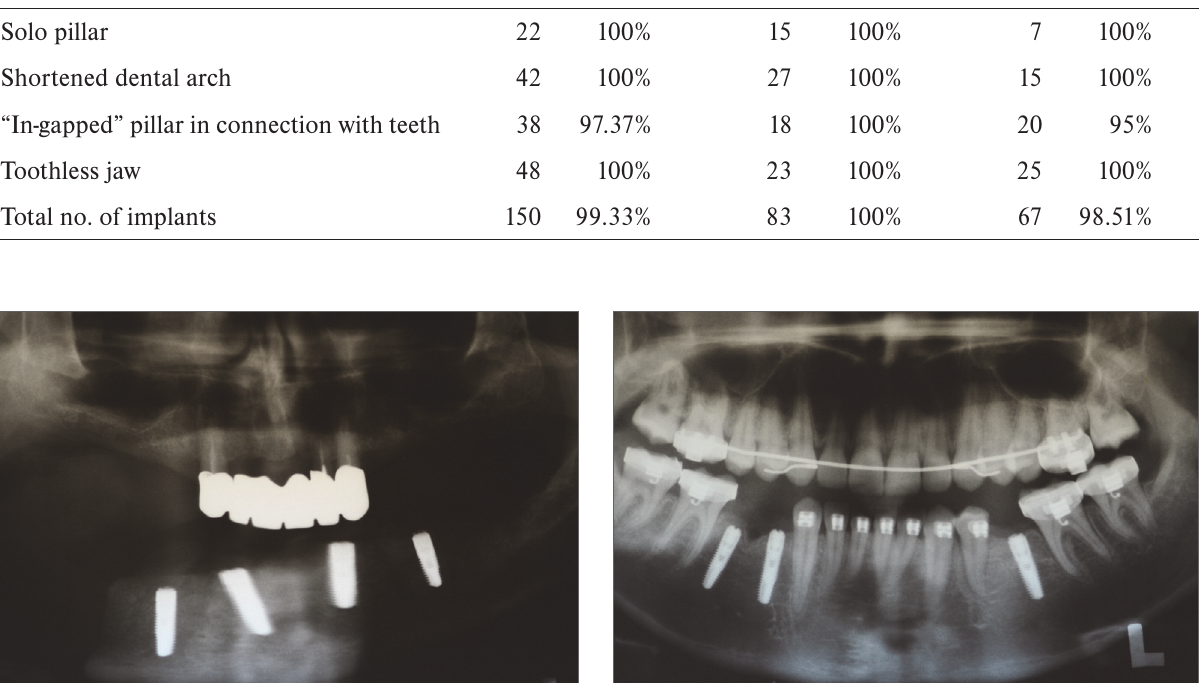
Table 1. Number of implants according to the indications of insertion and the success rate of the implantation within two years. Total / Success Rate Females / Success Rate Males / Success Rate